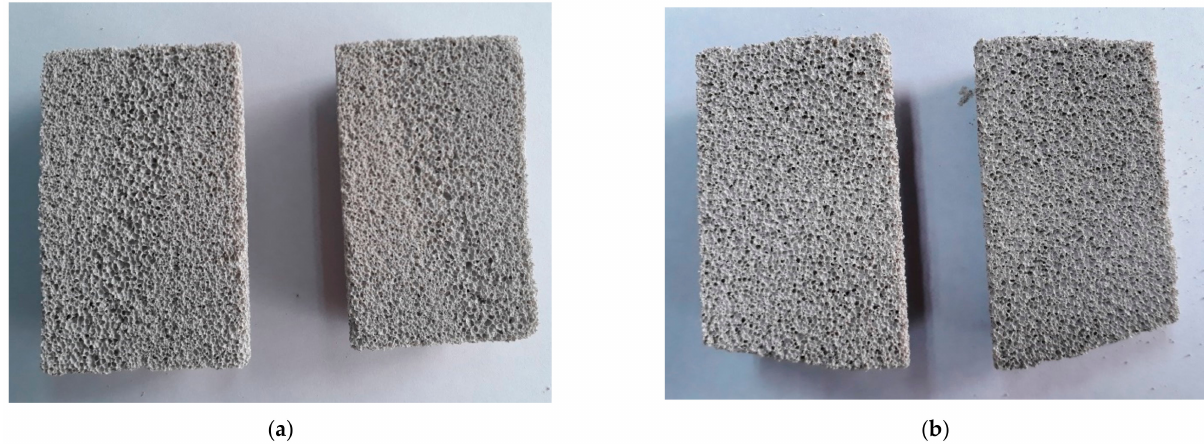
Figure 12. Triaxial compression tests: view of sawed samples after failure under a confinement level of ( a ) 0.33 fc and ( b ) 0.66 f c